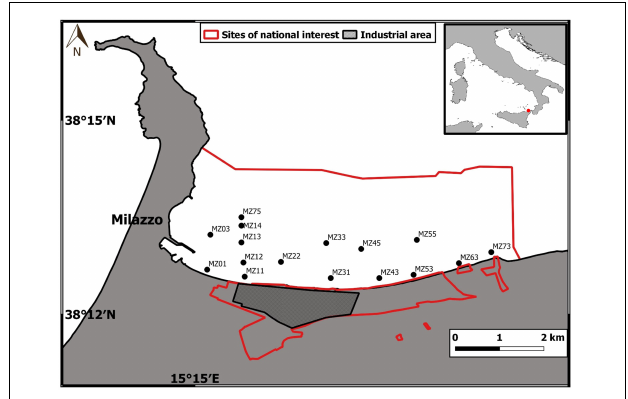
FIGURE 1 | Sampling stations in the study